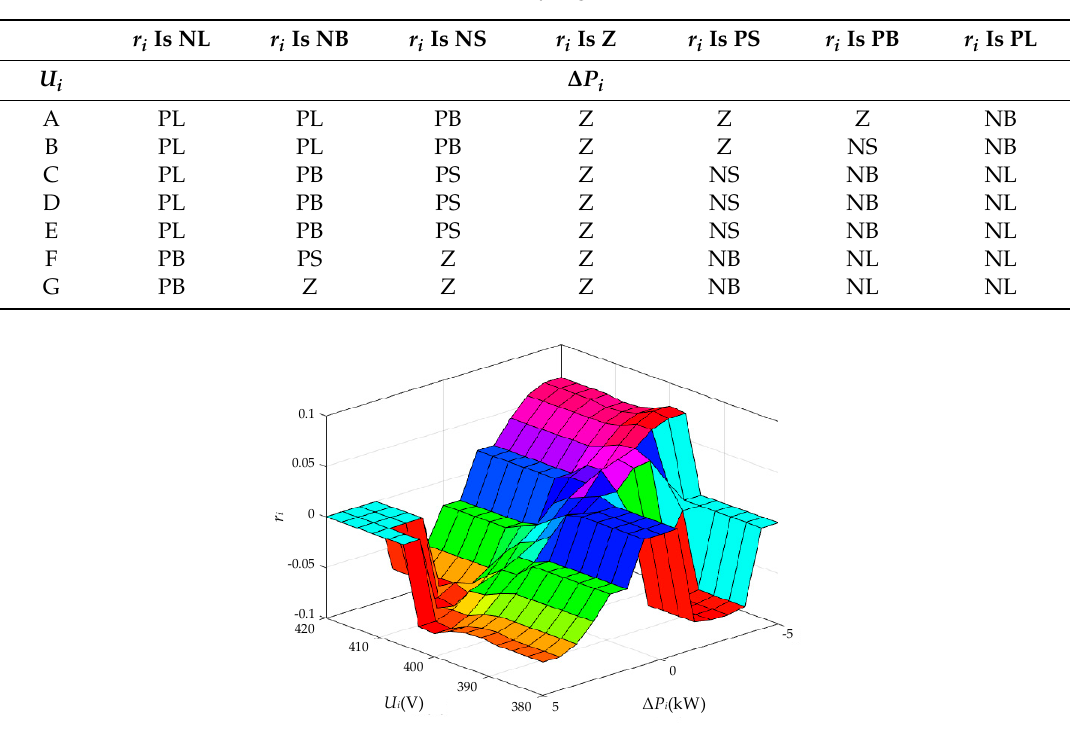
Table 1. Fuzzy logic rules.